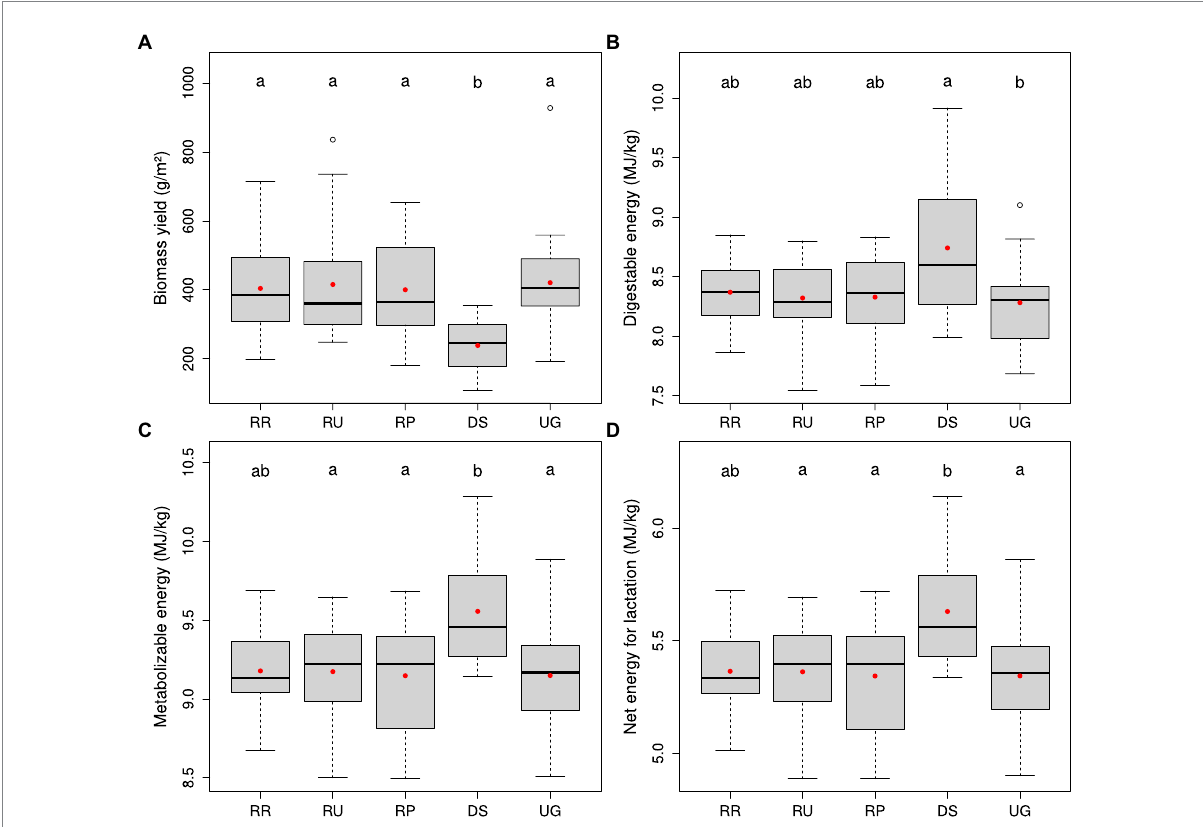
FIGURE 5 Box-whisker plots of the biomass yield (g/m 2 ; A ), the digestible energy for horses (MJ/kg; B ), the metabolisable energy for ruminants (MJ/kg; C ), and the net energy for lactation (MJ/kg; D ; all referring to dry matter) in 2021 on the different site categories—donor sites (DS, n = 8), all restoration sites with treatments ploughed (RP), rotovated (RR), and untilled (RU), and unrestored reference grassland (UG; n = 20, respectively). Plot data were averaged on the treatment level or, in case of DS and UG, on the site level. Red dots display the mean values. Significant differences ( p < 0.05) are indicated by different letters above the boxes (testing on ln-transformed data for biomass